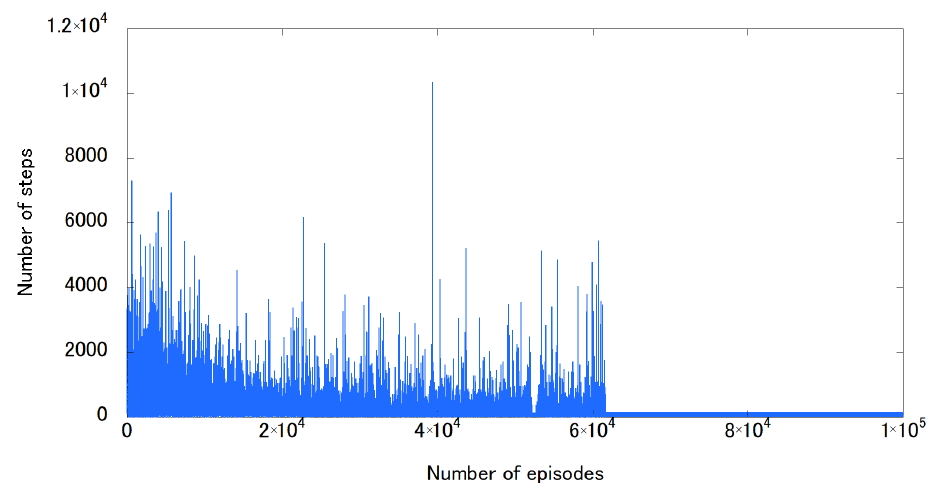
Figure 9. Learning curve obtained from learning simulation with virtual agents. The x-axis denotes the number of episodes, indicating the iteration number of learning. The y-axis denotes the number of steps between the start and goal positions. In other words, the number of steps represents the problem-solving time or number of action selections.